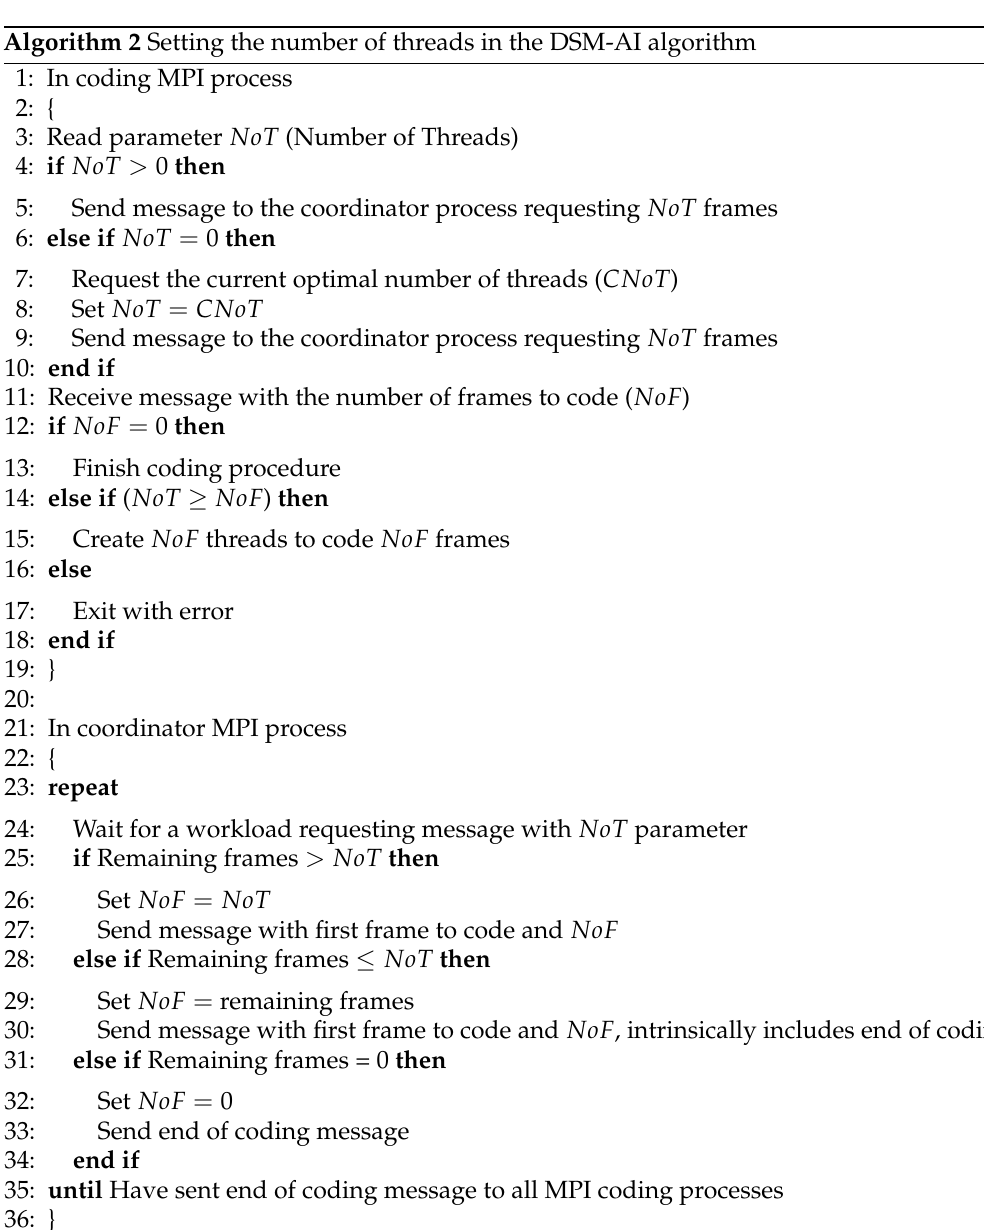
Algorithm 2 Setting the number of threads in the DSM-AI